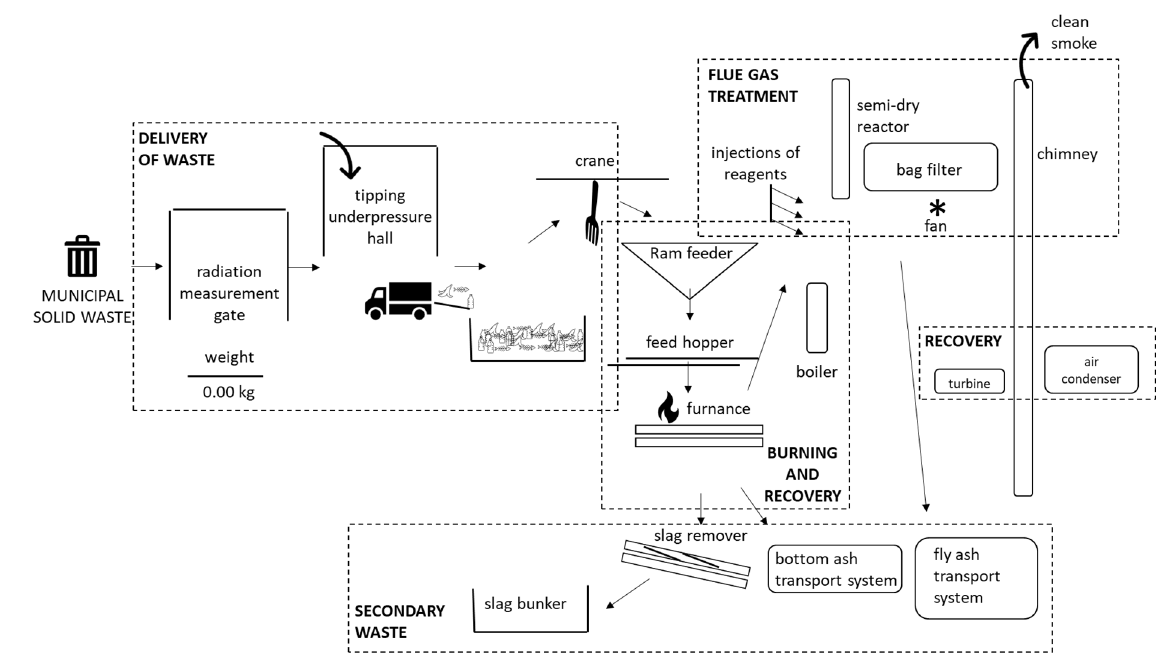
Figure 3. Incineration plant.